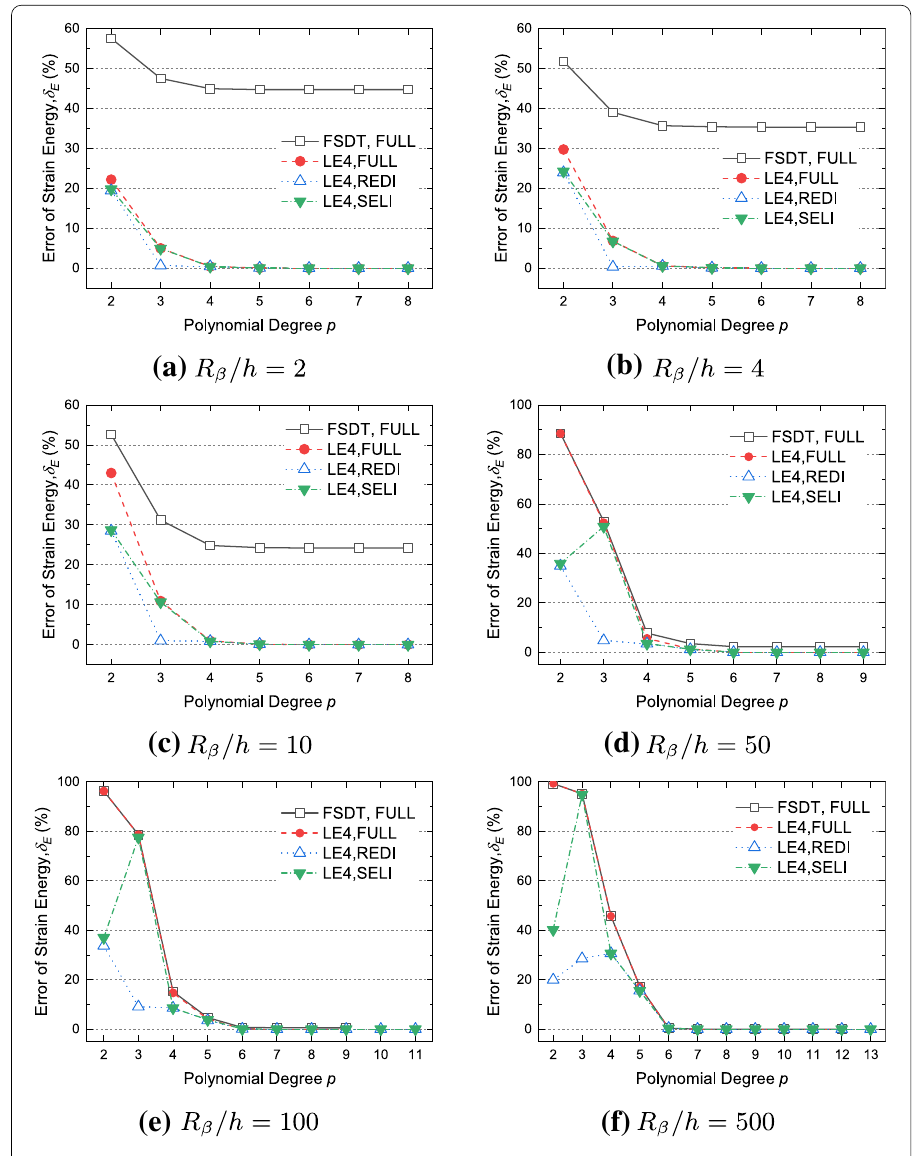
Fig. 9 Convergence regarding the strain energy of FE models for the three-layered cylindrical shells under distributed pressure, for various radius-to-thickness ratio R β / h